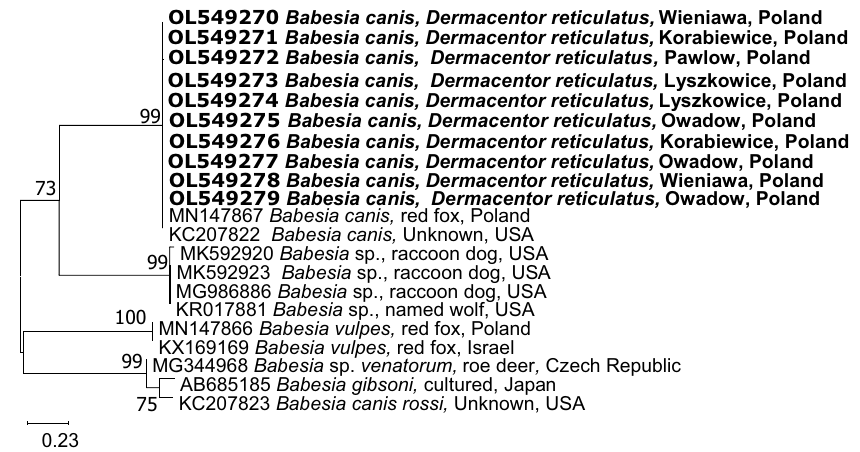
Figure 3. Molecular phylogenetic analysis of cox1 of Babesia spp. (328 bp). The evolutionary history was inferred by using the Maximum Likelihood method and Hasegawa-Kishino-Yano model. The tree with the highest log likelihood (− 1413.72) is shown. The percentage of trees in which the associated taxa clustered together is shown next to the branches. Initial tree(s) for the heuristic search were obtained automatically by applying Neighbor-Join and BioNJ algorithms to a matrix of pairwise distances estimated using the Maximum Composite Likelihood (MCL) approach, and then selecting the topology with superior log likelihood value. The tree is drawn to scale, with branch lengths measured in the number of substitutions per site. This analysis involved 21 nucleotide sequences. There were a total of 236 positions in the final